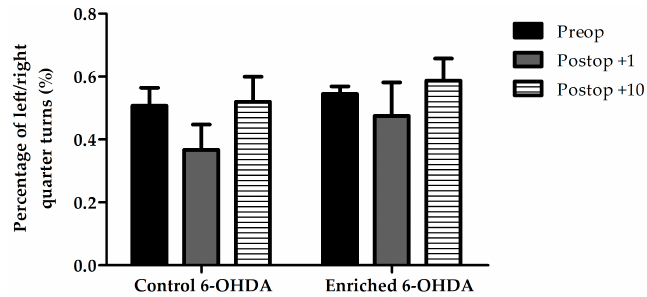
Figure 5. Percentage of left/right quarter turns in 6-OHDA-treated control and enriched animal groups before (Preop), 1 day, and 10 days after the lesion (Postop +1, +10, respectively). Values are given as given as mean ± S.E.M., where 100% = 1.0. mean ± S.E.M., where 100% =